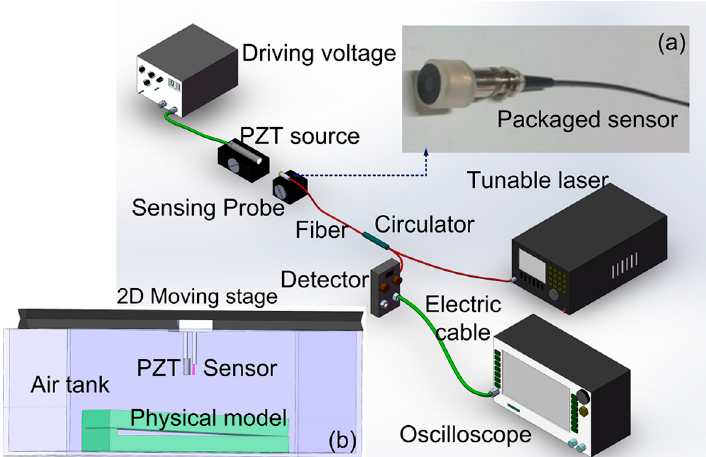
Figure 2. Schematic configuration of experiment setup for UW imaging, insets contain ( a ) photograph of sensor, and ( b ) schematic diagram of scanning imaging for physical models.